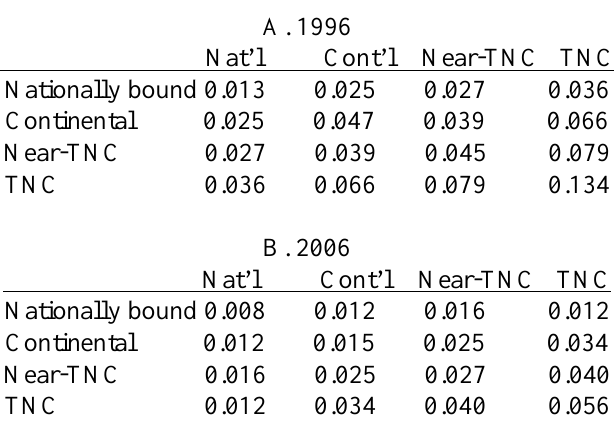
Table 5. Sectoral Densities Within and Between Categories of